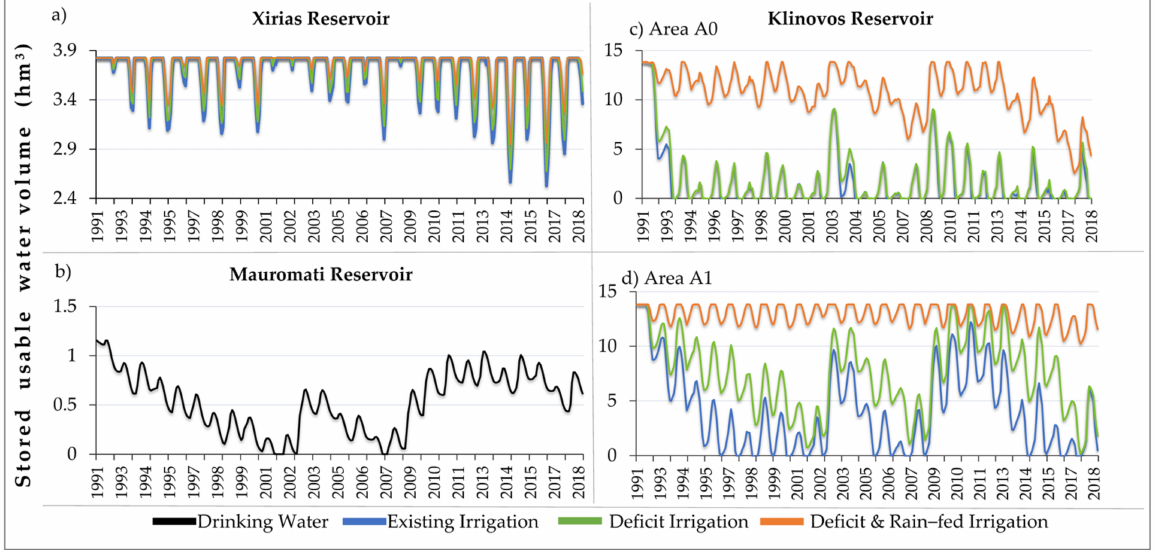
Figure 5. Stored Water Volume for ( a ) Xirias reservoir, ( b ) Mavromati reservoir, ( c ) Klinovos reservoir for Area A0, and ( d ) Klinovos reservoir for Area A1 for the various irrigation